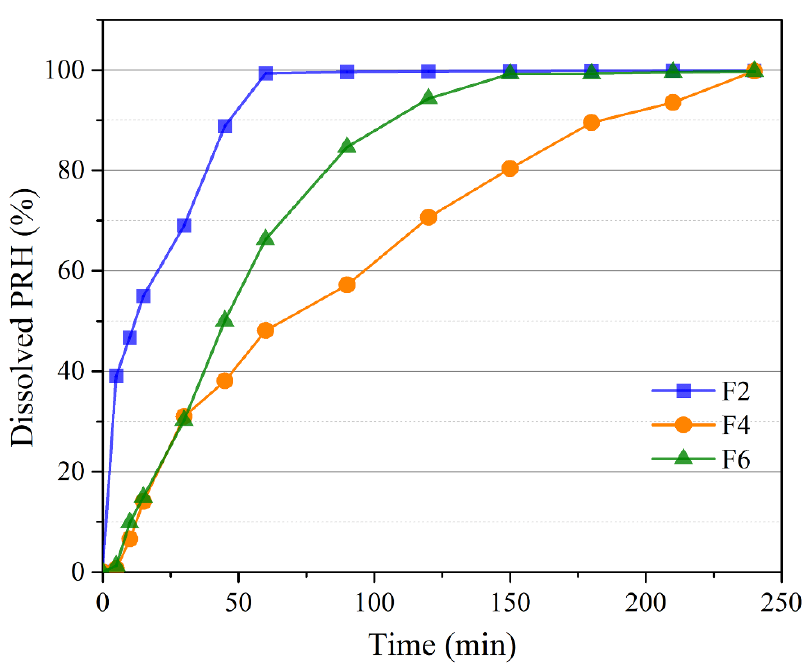
Figure 5. In vitro drug release.